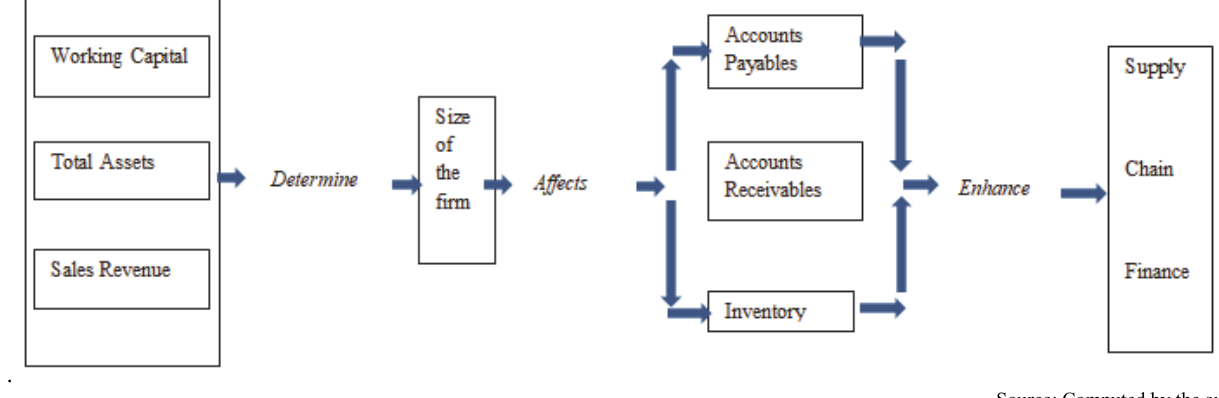
Fig. 3. Results of the research